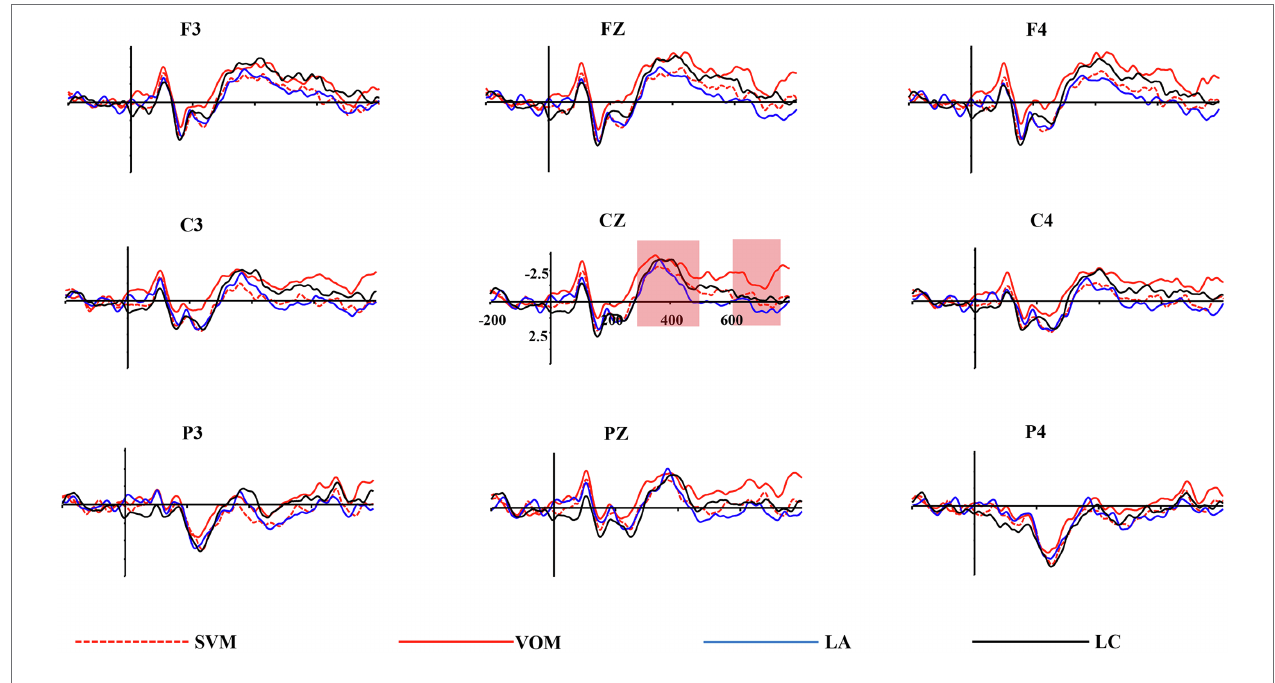
FIGURE 2 | Grand average ERP waveforms recorded at verb for the chosen electrodes.